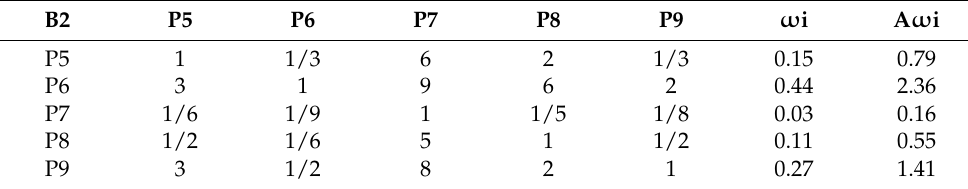
Table 8. B2-P comparison matrix.